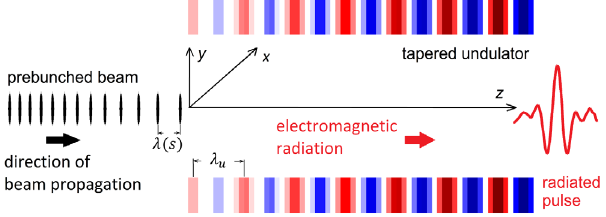
FIG. 2. Schematic of a tapered undulator and a prebunched beam. The distance between the bunches s changes as the radiation wavelength along the undulator impulse λ